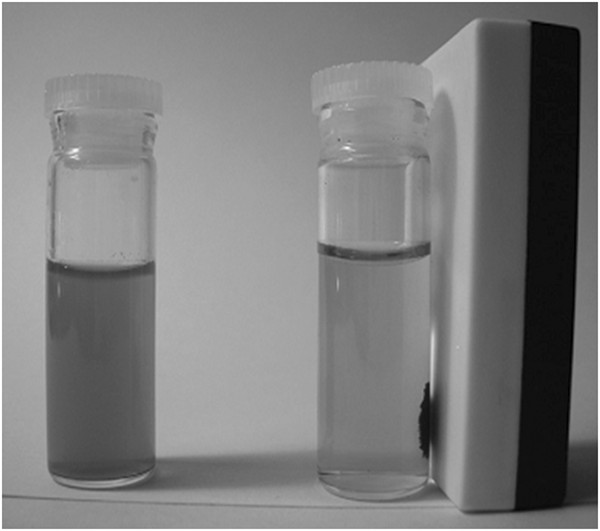
Magnetite-hexane suspension attached to a magnet.